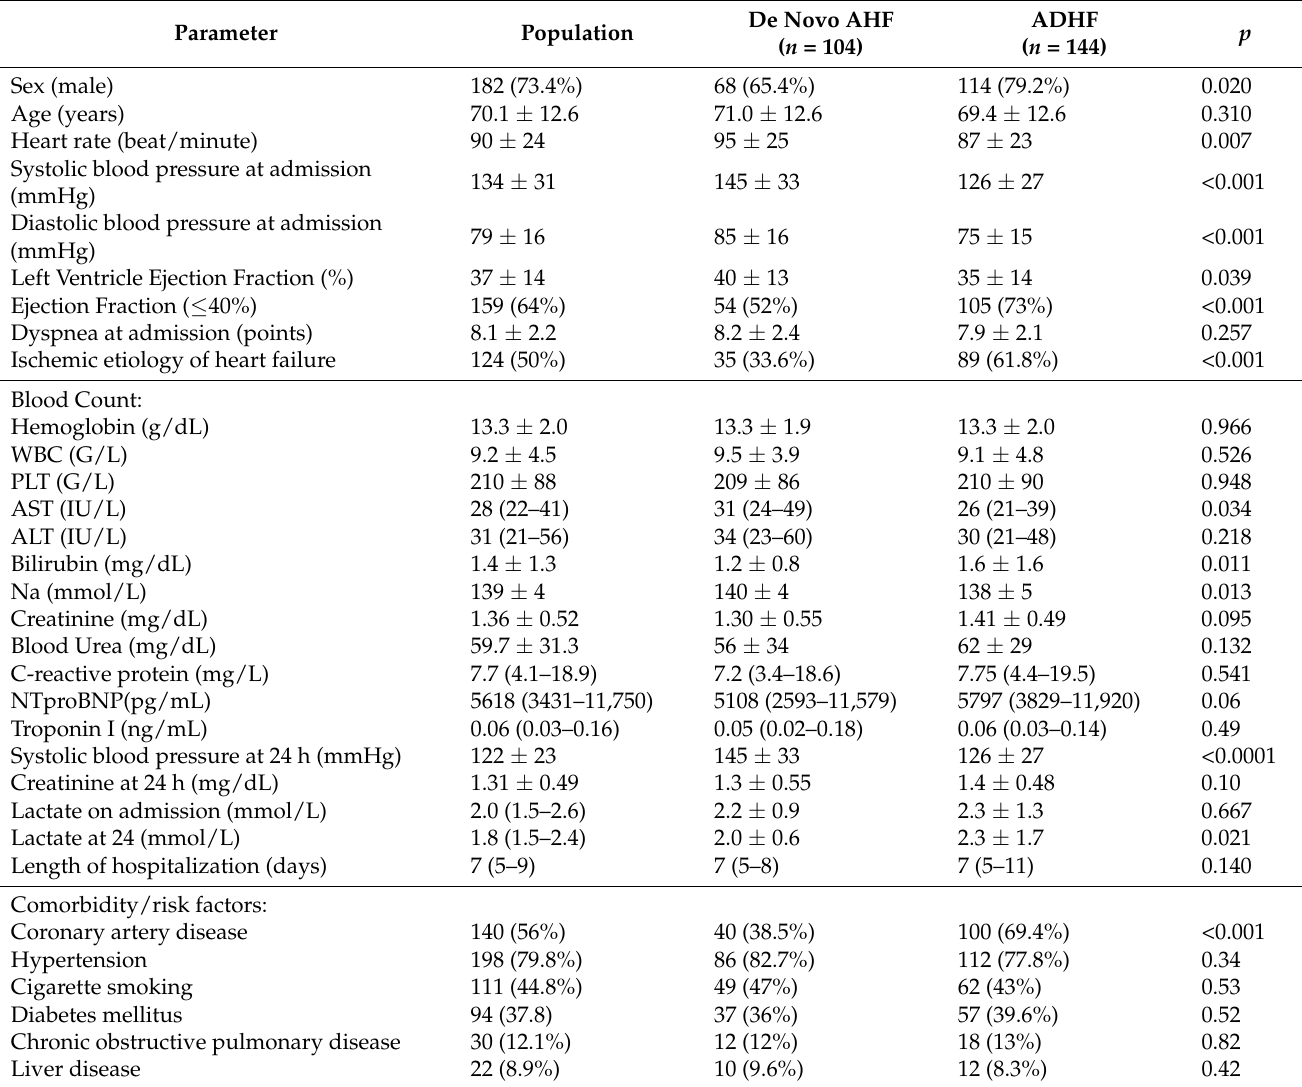
Table 1. Baseline characteristics of the